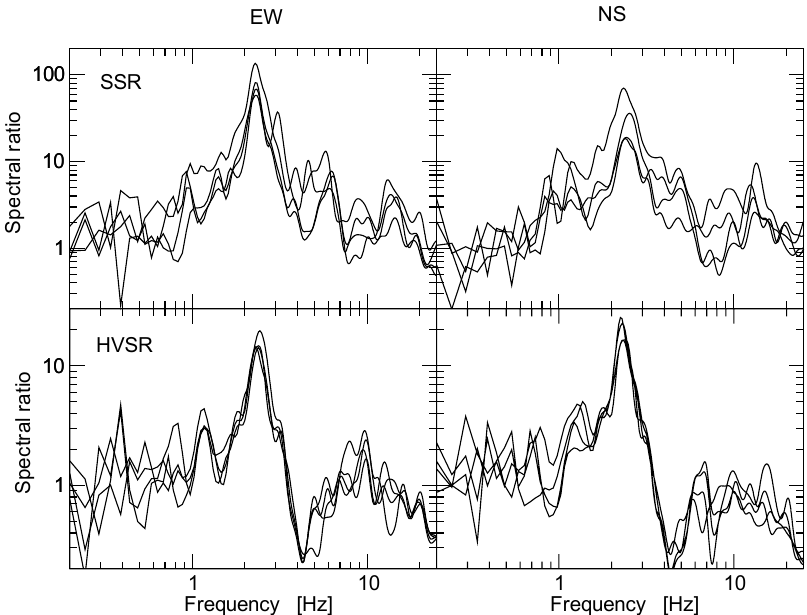
Figure 5. Site amplification at station EST determined from aftershock analysis. The two upper diagrams show the results of spectral ratios relative to a reference site (SSR) technique (CAL is the reference station) for the two horizontal components. The two bottom diagrams show the corresponding result using the horizontal relative to the vertical component (HVSR) technique.